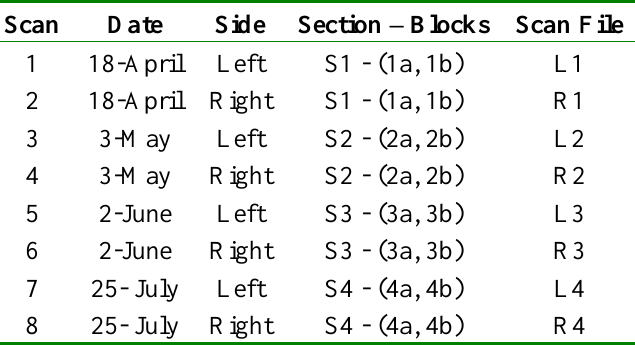
Table 2. List of scans, performed on four different dates, of four sections of vegetation at a commercial pear tree orchard ( Pyrus communis L. cv. Blanquilla) in Lleida, Spain.